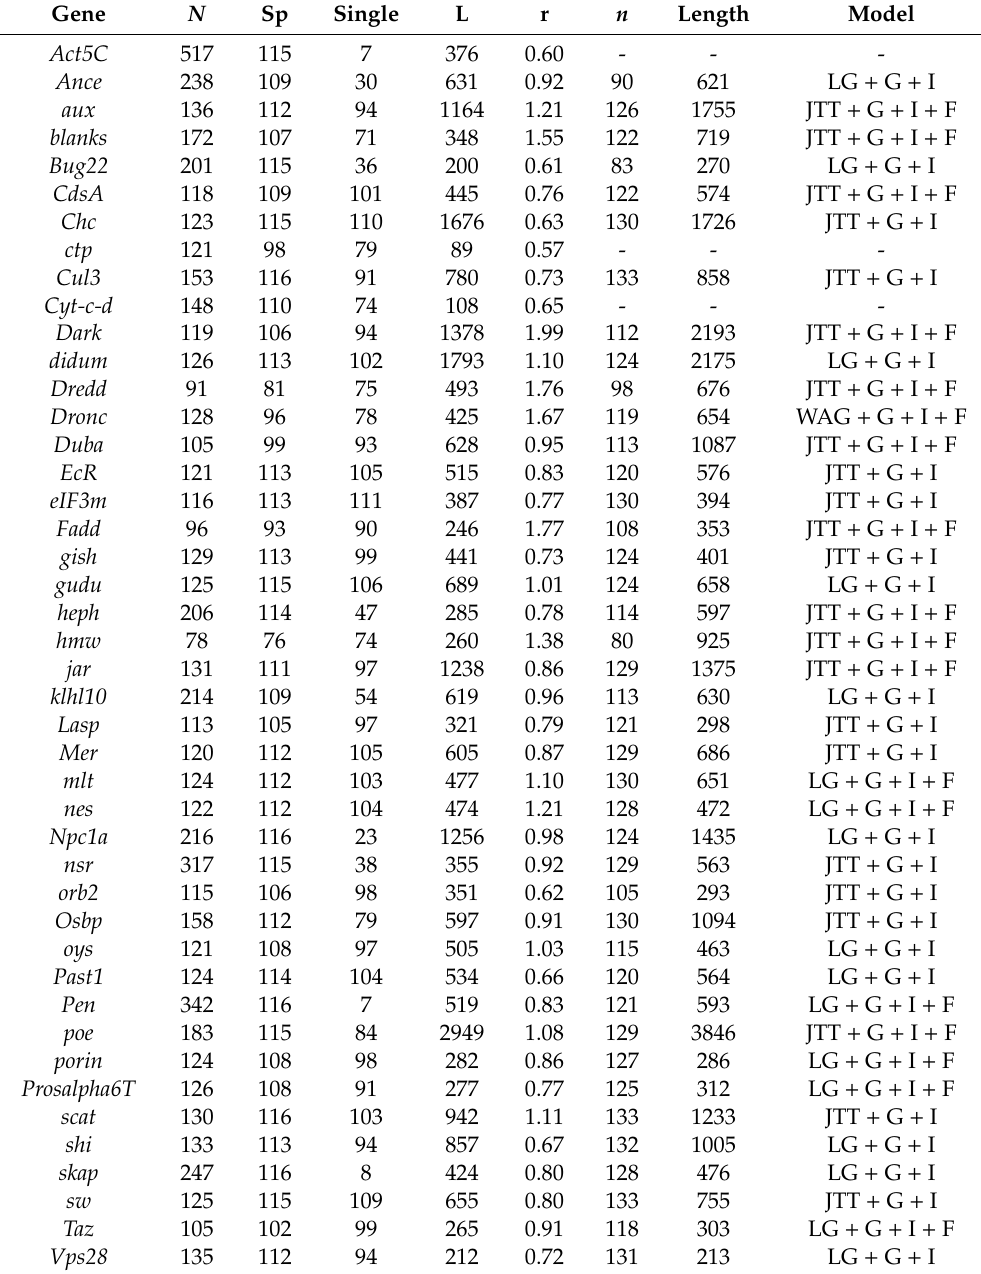
Table 3. Summary of sequence characteristics of genes retrieved from OrthoDB. The table lists the number of sequences (N) and species (Sp; with a maximum of 119 species), number of species in which the gene is single copy (Single), the median protein length (L), and relative evolutionary rate (r) as tabulated in OrthoDB. Furthermore, the number (n) of aligned sequences in this study and the alignment lengths (Length), as well as the inferred optimal evolutionary model, are